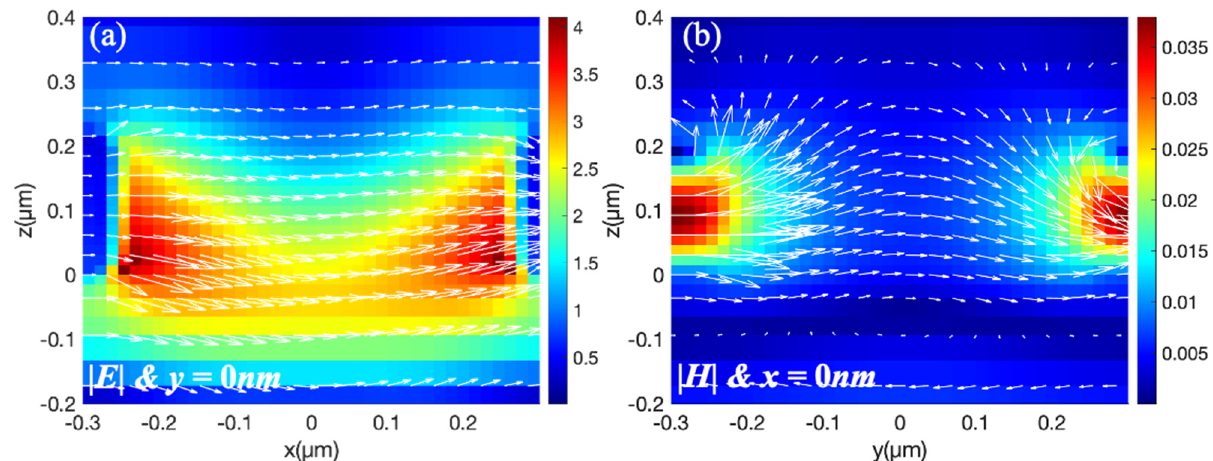
Figure 3. Electric field distributions of the reflection peak marked in Figure 2b: ( a ) Normalized electric field distribution on the x - y plane with z = 100 nm; ( b ) Normalized electric field distribution on the x - z plane with y = 0.